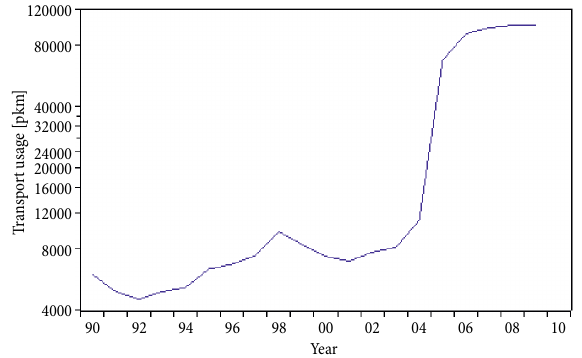
Fig. 2. Maritime passenger transport usage in